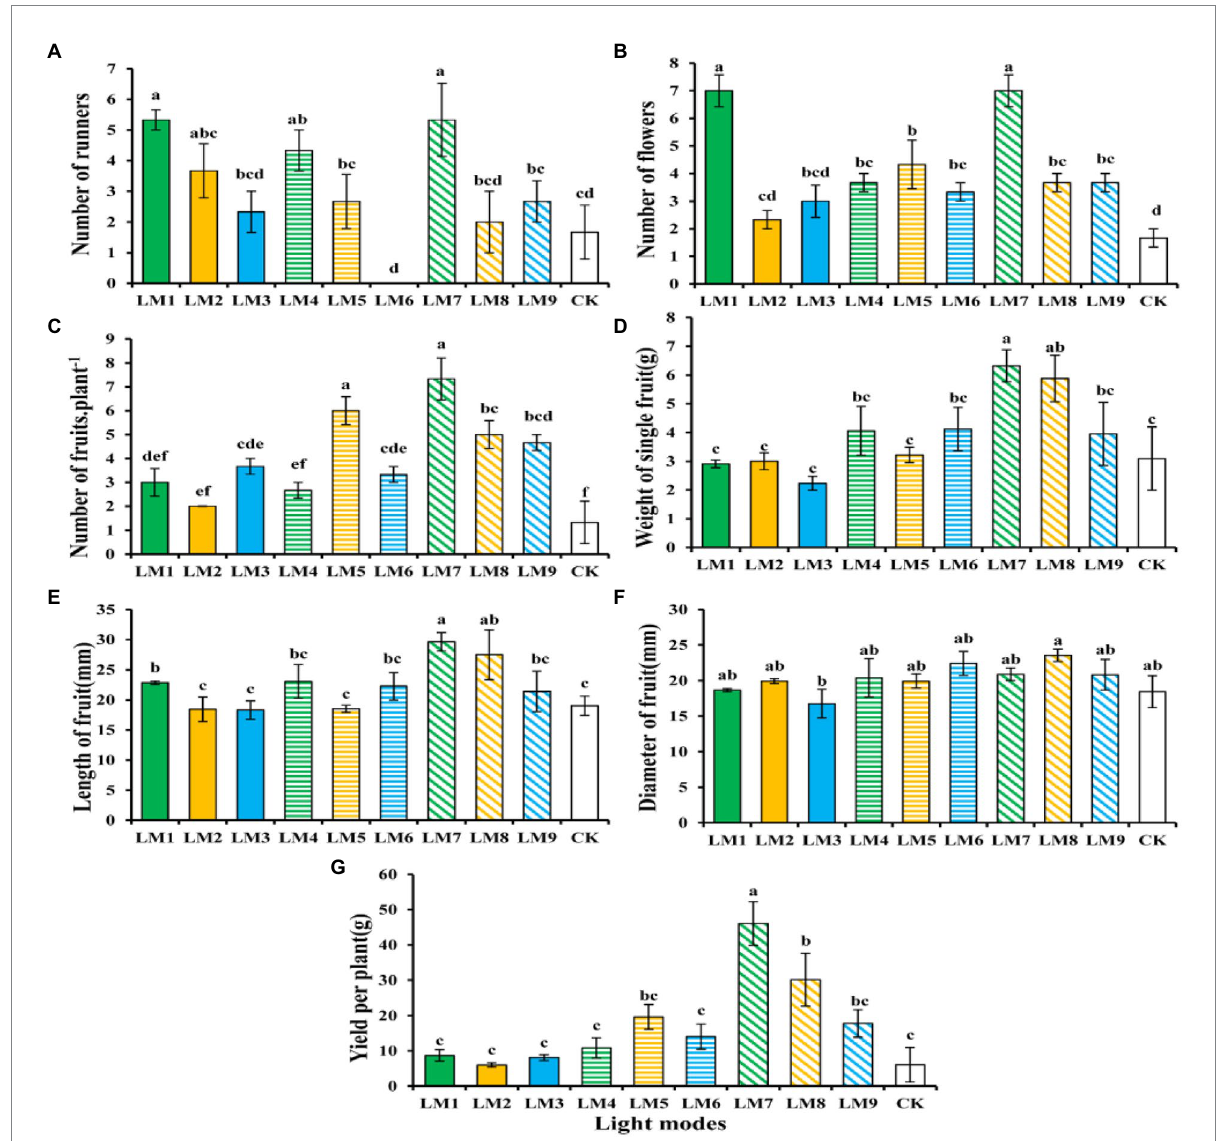
FIGURE 11 The influence of modes of LED light on vegetative [Number of runners (A) ], flowering [Number of flowers (B) ], and fruiting parameters [Number of fruits plant − 1 (C) , Weight of single fruit (G,D) , Length of fruit (E) , Diameter of fruit (F) , and Yield per plant (G) ] of strawberry plants. Each column represents the means of three technical replicates ( n = 5); the same letter within the same series is not significantly different according to Duncan’s multiple range test ( p ≤